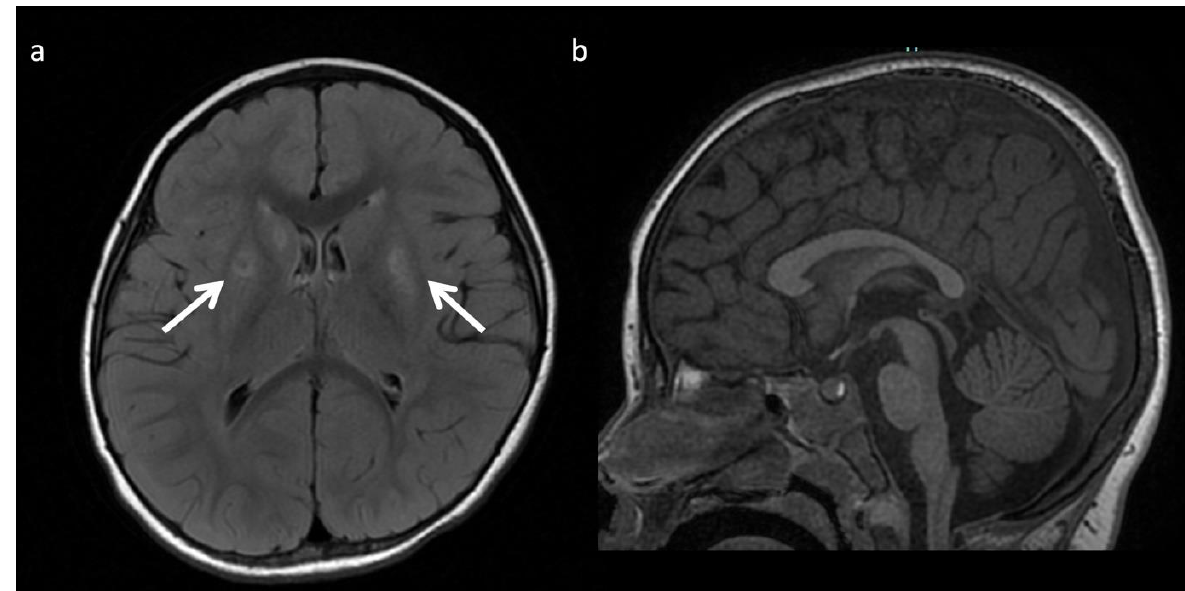
Figure 16. Pyruvate dehydrogenase complex (PDHc) deficiency in a 30-month-old female with desaturations. ( a ) Axial T2 FLAIR image shows a Leigh pattern of brain injury with bilateral putamen and right caudate head (white arrows) hyperintense lesions with central signal suppression representing necrosis. ( b ) Sagittal T1WI shows mild pontine hypoplasia and thinning of the callosal splenium, likely representing regional hypogenesis rather than volume loss, given low normal callosal length and normal cerebral white matter